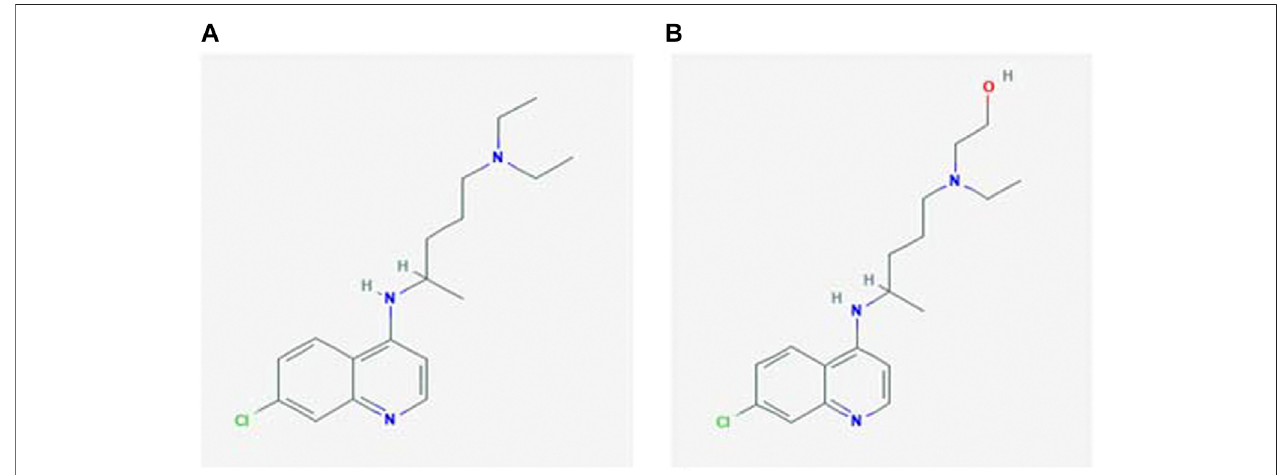
FIGURE 1 | Chemical structure of (A) chloroquine and (B) hydroxychloroquine (National Center for Biotechnology Information, 2004).